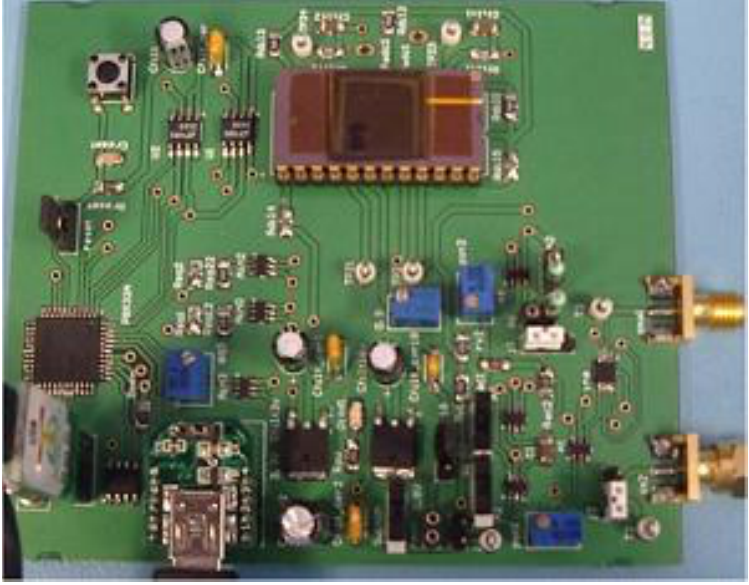
Figure 6. Photograph of the proposed portable electronic interface, with dimensions 85 × 99 mm 2